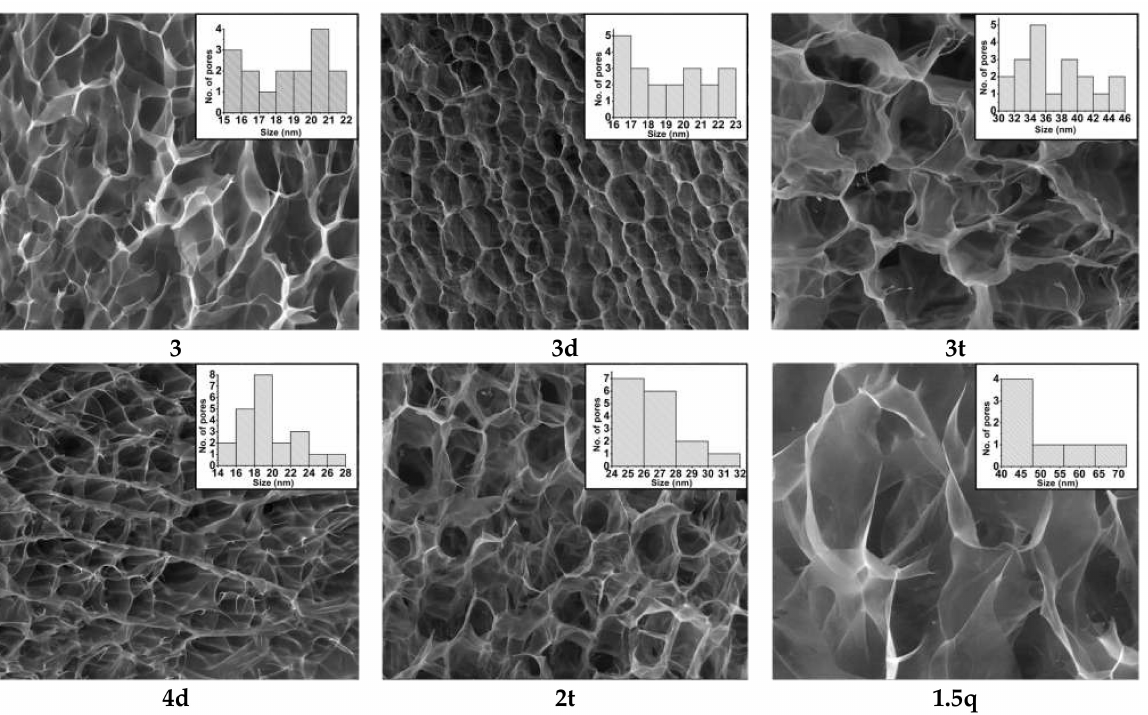
Figure 2. SEM images for representative xerogels (scale bar: 50 µ m) and corresponding histograms (to be representative, the samples given in figure have different molar ratio of glucosamine/aldehyde units and/or different water volumes).